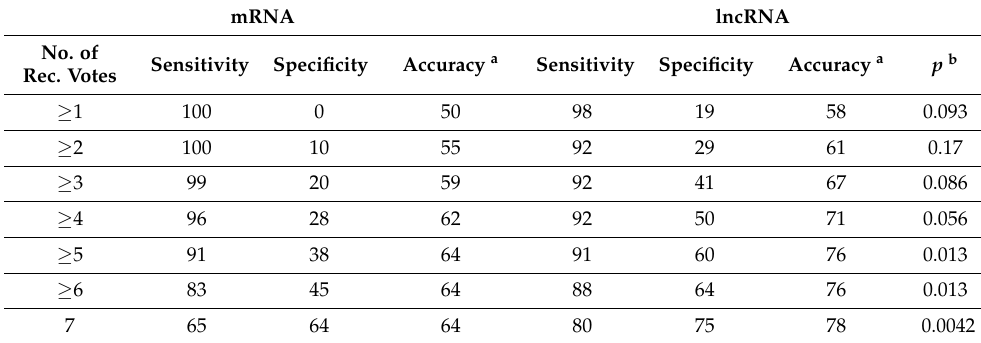
Table 3. Integrated voting results following classification with ≥ 90% sensitivity